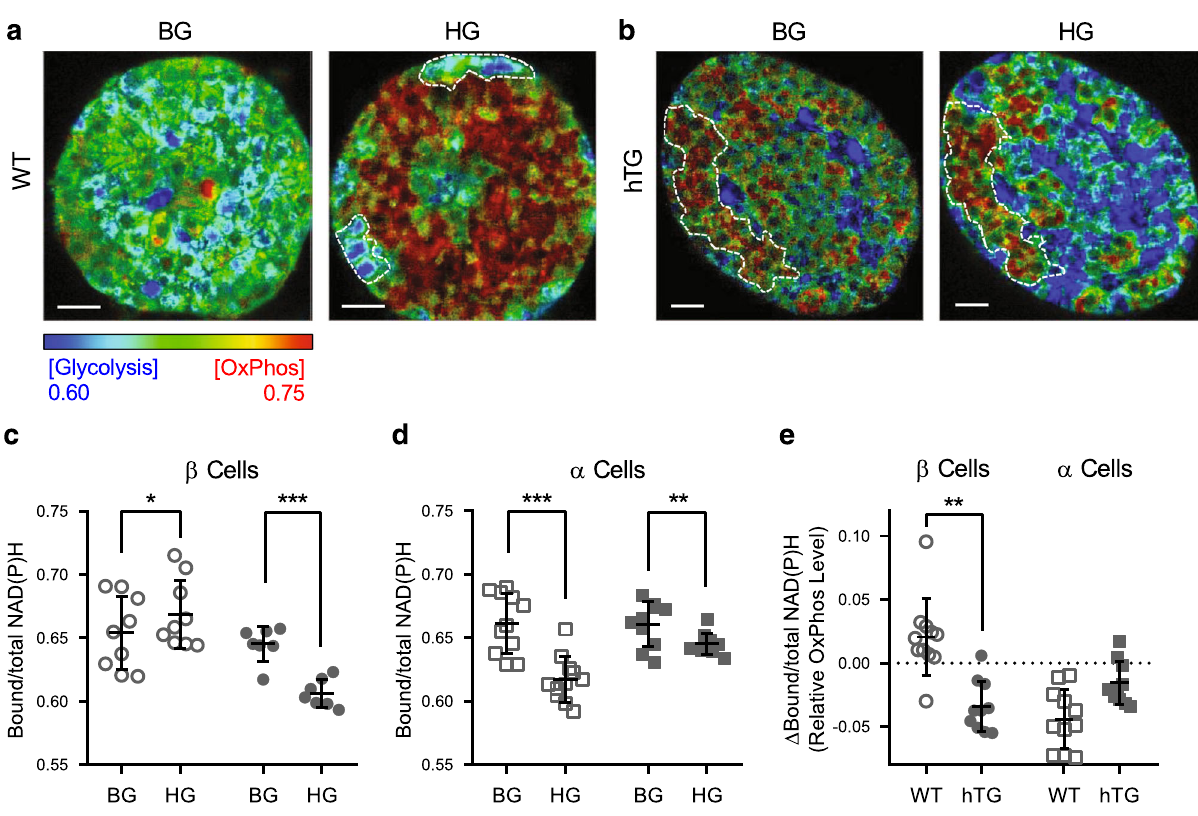
Fig. 3 Impact of protein misfolding stress characteristic of T2D on metabolic trajectory of β and α cells in response to glucose. FLIM images depicting relative glycolysis and OxPhos in islets from a wild type (WT), ( a ) and human IAPP transgenic (hTG), ( b ) mouse islet at basal glucose (BG, 4 mM) and high glucose (HG, 16 mM). c, d Panels show Bound/total NAD(P)H value for β cells and α cells respectively in WT (open circle and square) and hTG (solid circle and square) mouse islets at BG and HG. e Relative increase ( + ) or decrease ( − ) in OxPhos ( Δ Bound/total NAD(P)H) in α and β cells from WT and hTG mouse islets after increase in glucose from BG to HG. Data are presented as mean ± SD, n = 11 for WT islets, 1 – 3 islets from 6 mice, n = 10 for hTG islets, 1 – 3 islets from 4 hTG mice. * P < 0.05, ** P < 0.01, *** P < 0.001; the linear mixed effect models were used for statistical analysis. Scale bar, 10 µ